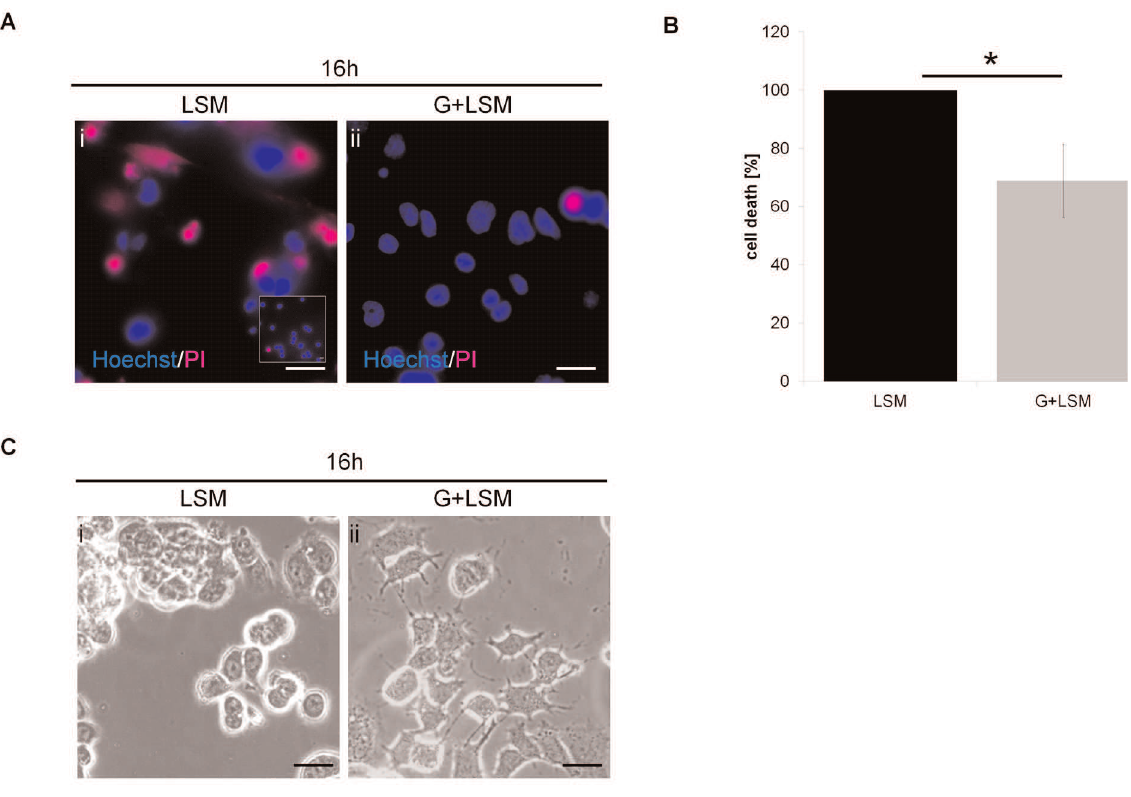
Figure 2. 1.5x10 5 PC12 cells were cultured on collagen-s-coated chamber slides in FSM. Medium was then changed to LSM and PC12 cells were stimulated with LSM or guanosine 500 m M (G+LSM). (A) Cell death was analyzed 16h later by staining the cells with Hoechst (total cell number, blue) and propidium iodide (PI, dead cells, pink). The small insert shows a representative picture of PC12 cells in FSM. (B) The percentage of cell death was calculated [pink cells x 100/total cell number] with the percentage of cell death in LSM-treated cells set to 100%. (C) Phase contrast microscopy revealed that upon additional stimulation with guanosine (G+LSM) the ability to form neurite outgrowth was enhanced. Pictures are representative for 7 independent experiments and values represent the mean – SEM, n = 7. Scale bar, 40 m m. Differences were analyzed using unpaired one-tailed t- test: * p =